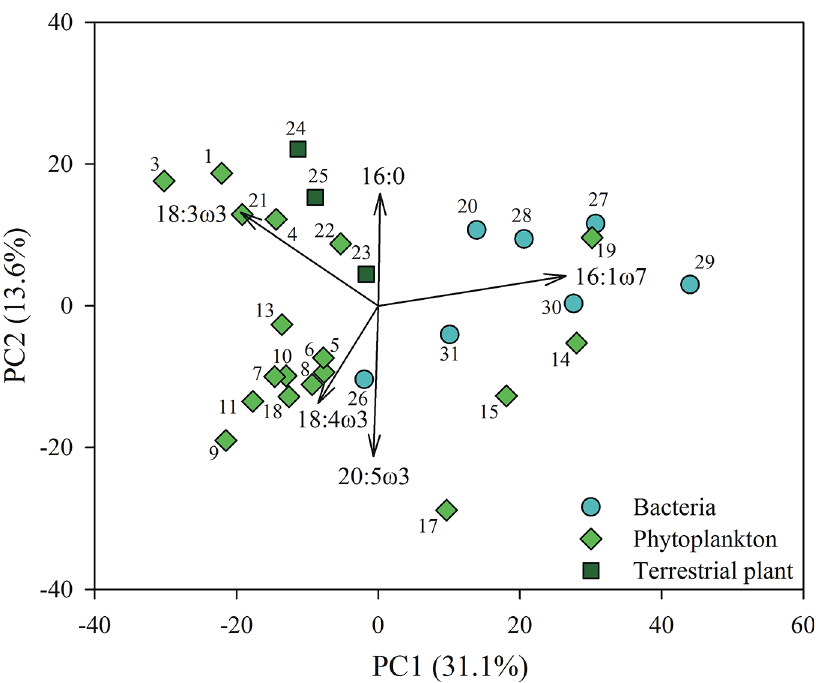
Fig 1. Fatty acid profiles of phytoplankton, bacteria and terrestrial plants. Principal component analysis (PCA) of the fatty acid composition of the phytoplankton, bacteria and terrestrial plants. Proportion of explained variance is in parentheses. PCA was run with all 67 fatty acids, but only eigenvectors > 0.3 are